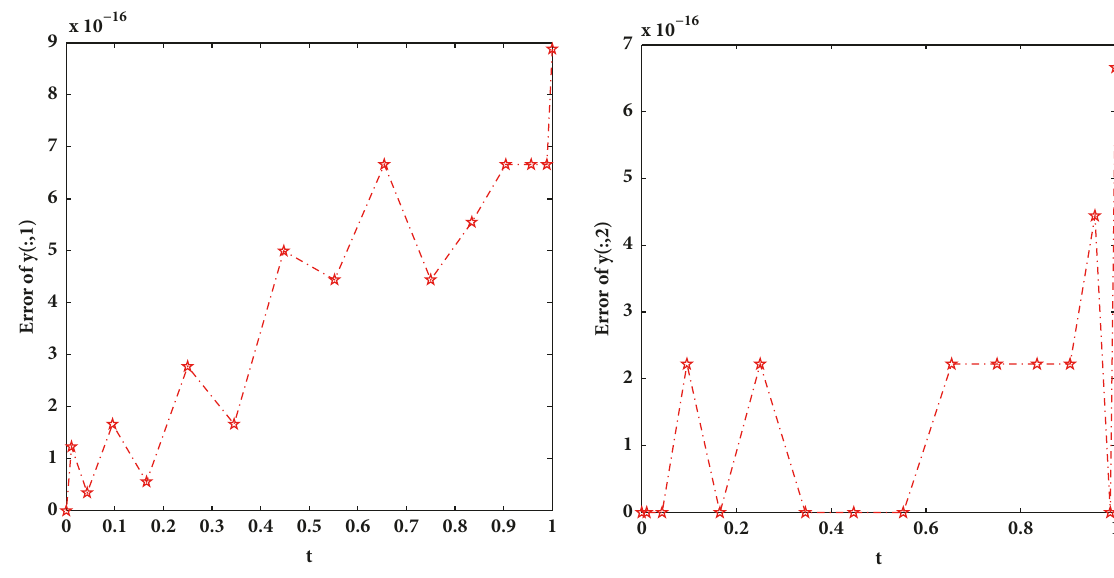
Figure 1: Errors of 𝑦 1 and 𝑦 2 for Example 1 when 𝑁 = 16 .